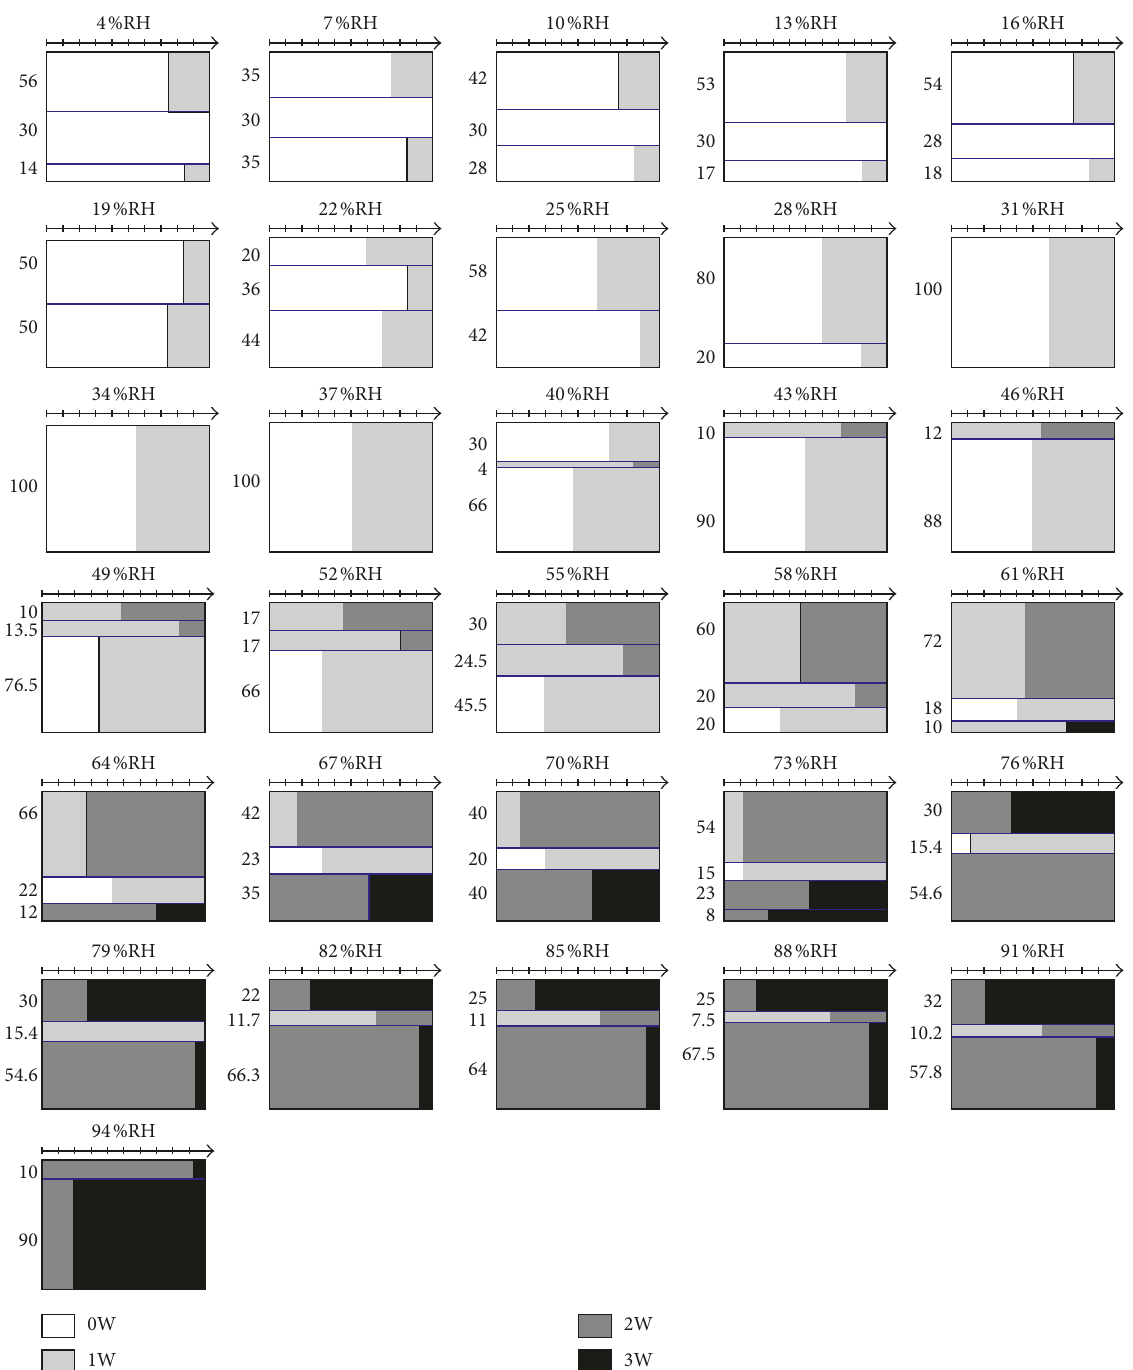
Figure 6: Schematic representation of the MLS used to fit the experimental XRD pattern in the case of the stressed sample along the sorption